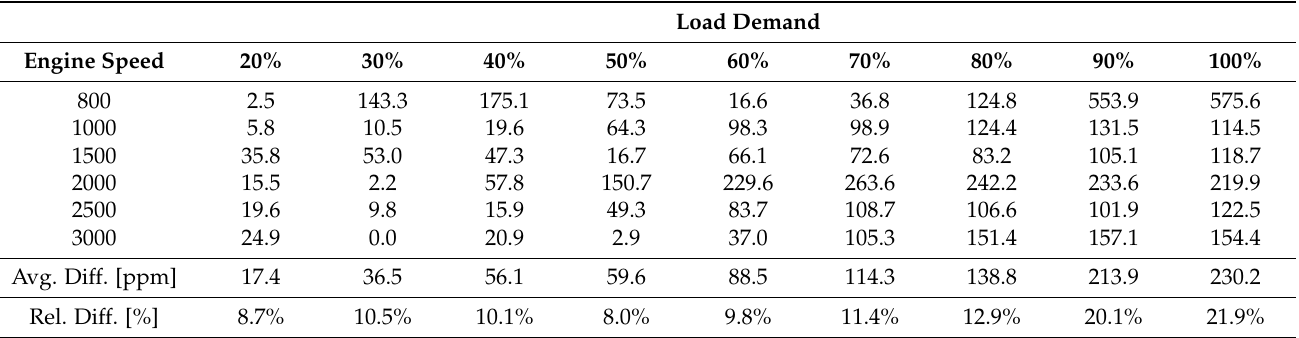
Table 5. Summary of the average absolute differences (ppm NO x ) between Tekber and Horiba equipment without